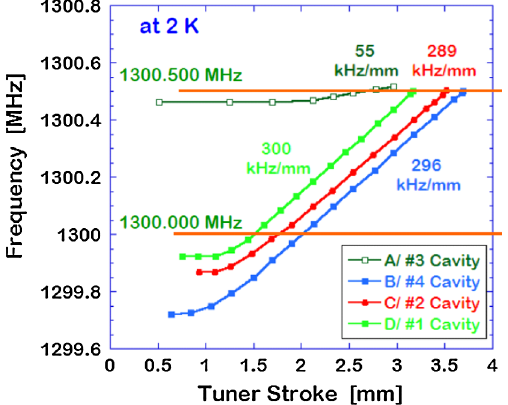
FIG. 12. (Color) Cavity resonant frequency vs tuner stroke equivalent to changing a total cavity length driven by the